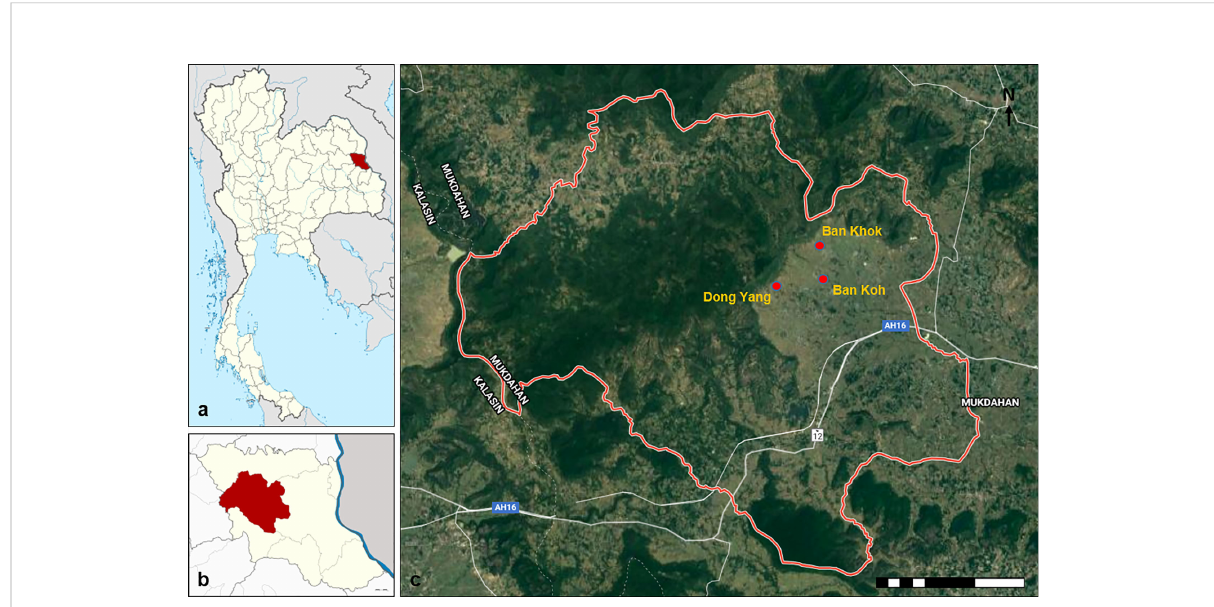
FIGURE 1 Map of the study area. (A) Map of Thailand showing the location of Mukdahan Province (red). (B) Map of Mukdahan Province showing the location of Khamcha-i district (red). (C) The location of the three study villages within the Khamcha-i